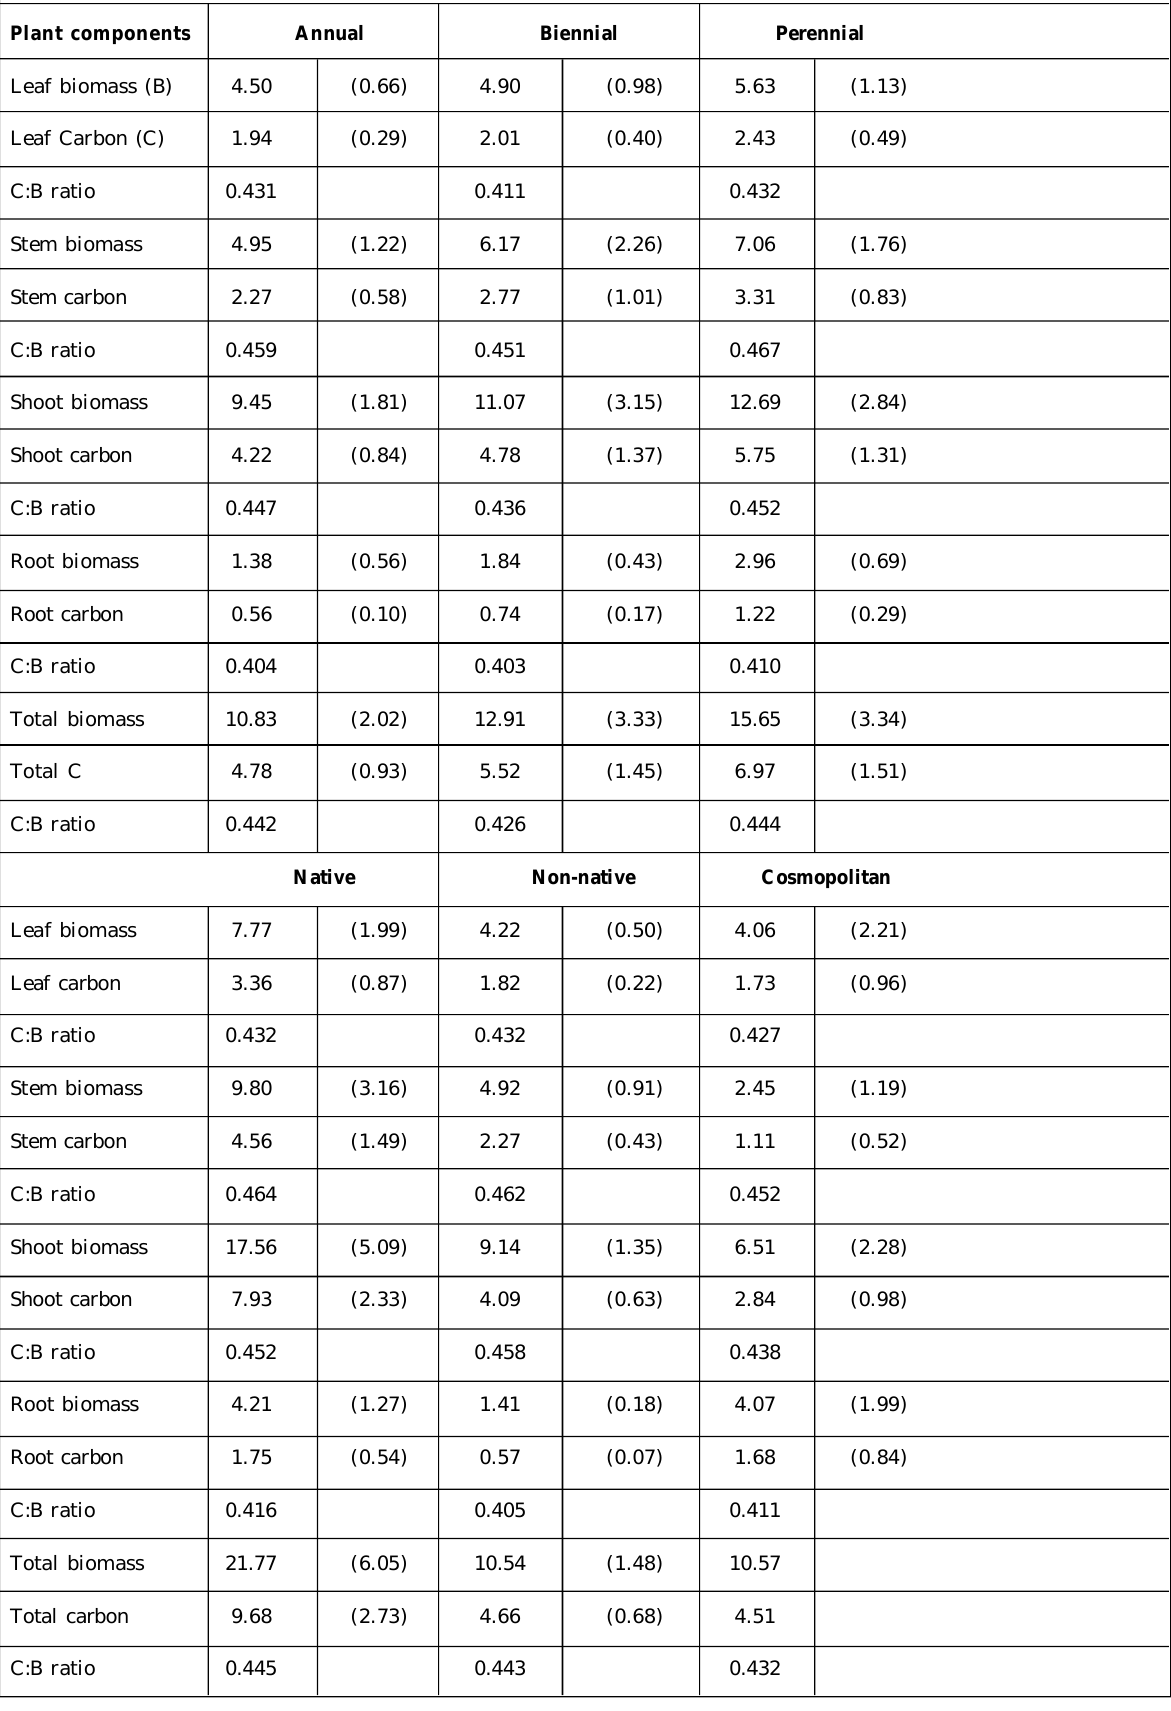
Table 2: Mean herbaceous biomass; B (g plant -1 ), carbon; C (g plant -1 ), C to B ratios and for different plant trait categories in tropical grassland. Values in parentheses are ± 1 SE